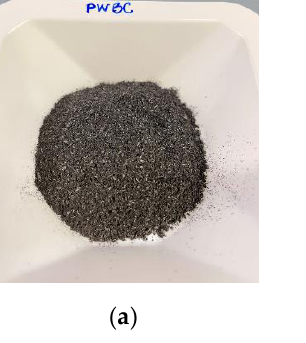
Figure 1. Photos of the investigated materials: (a) PWBC, (b) RHBC and (c) EuFeBC.